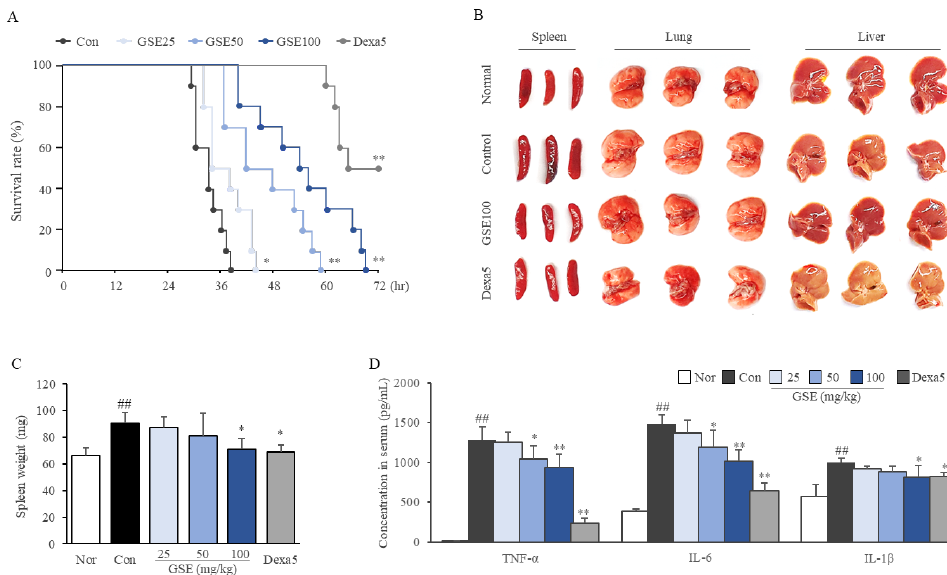
Figure 2. Effects of GSE on survival rate and systemic inflammation. GSE (25, 50, 100 mg/kg) or distilled water was administered by gavage for 5 days (twice per day) to each group of animals ( n = 15/group). On the final day, all mice were intraperitoneally injected with dexamethasone (5 mg/kg) or normal saline 30 min before LPS injection. After injection of LPS (30 mg/kg), ten mice from each group were monitored to evaluate their survival for 72 h ( A ). Furthermore, 12 h after LPS injection, five mice from each group were sacrificed, and three types of tissues (spleen, lung, and liver) were photographed ( B ). The spleens were weighed ( C ), and the concentrations of serum proinflammatory cytokines ( D ) were determined using ELISAs. Mice or samples were grouped according to treatment: normal (Nor), control (Con), ginseng sprout extract (GSE), and dexamethasone (Dexa5). The data are presented as the mean ± SD. ## p < 0.01 compared with the normal group; * p < 0.05, ** p < 0.01 compared with the control